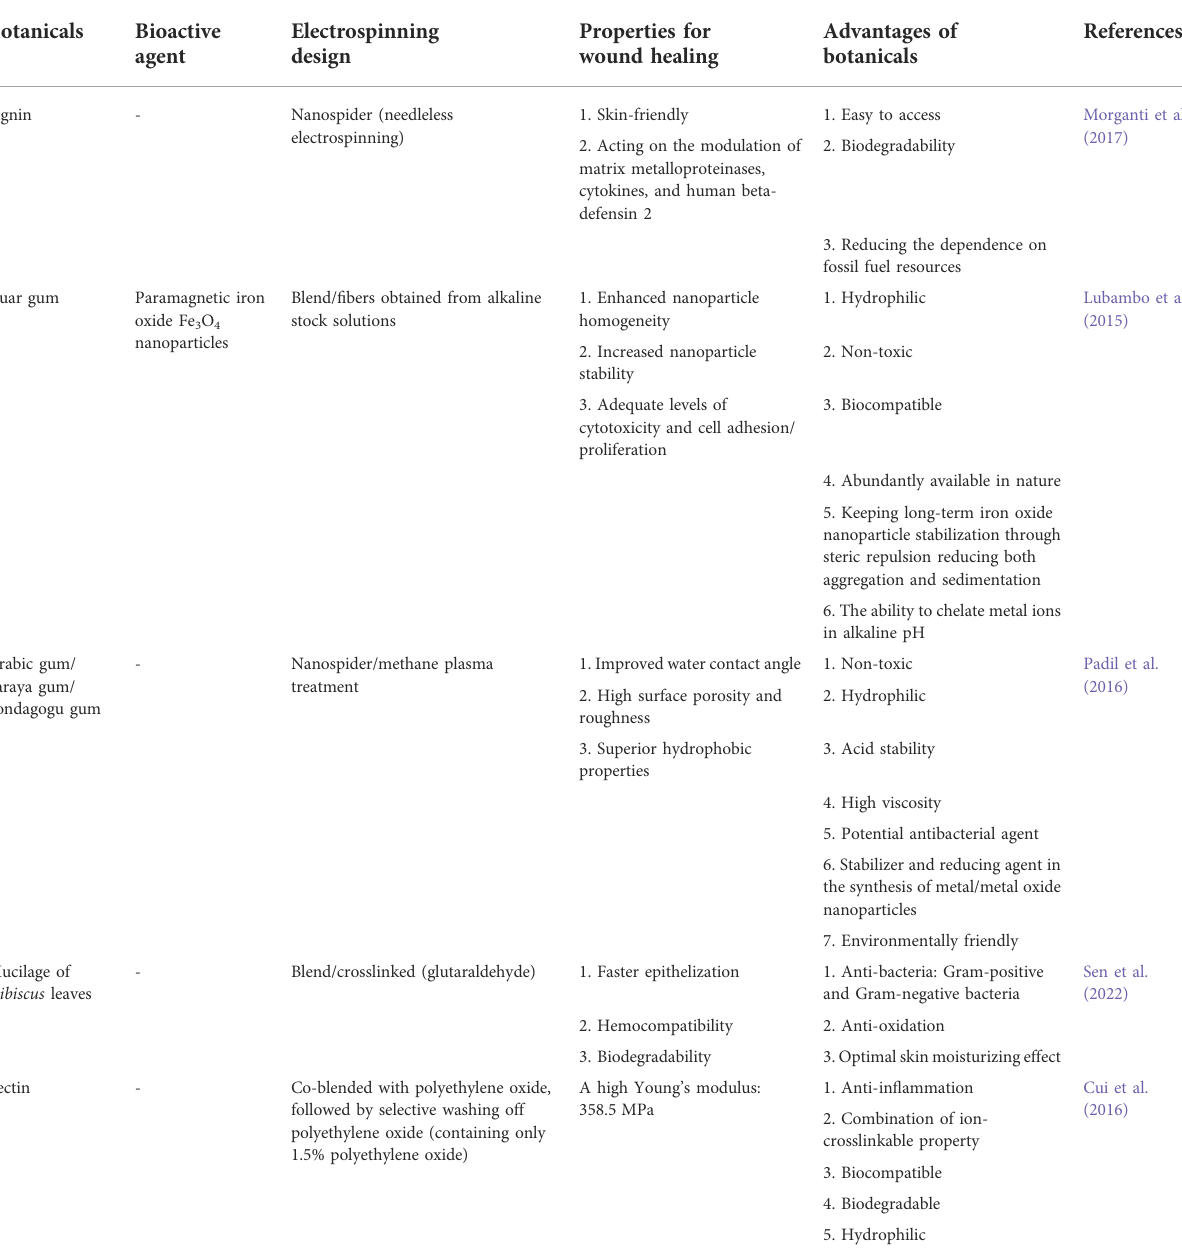
TABLE 2 Botanicals as carriers in electrospinning for wound